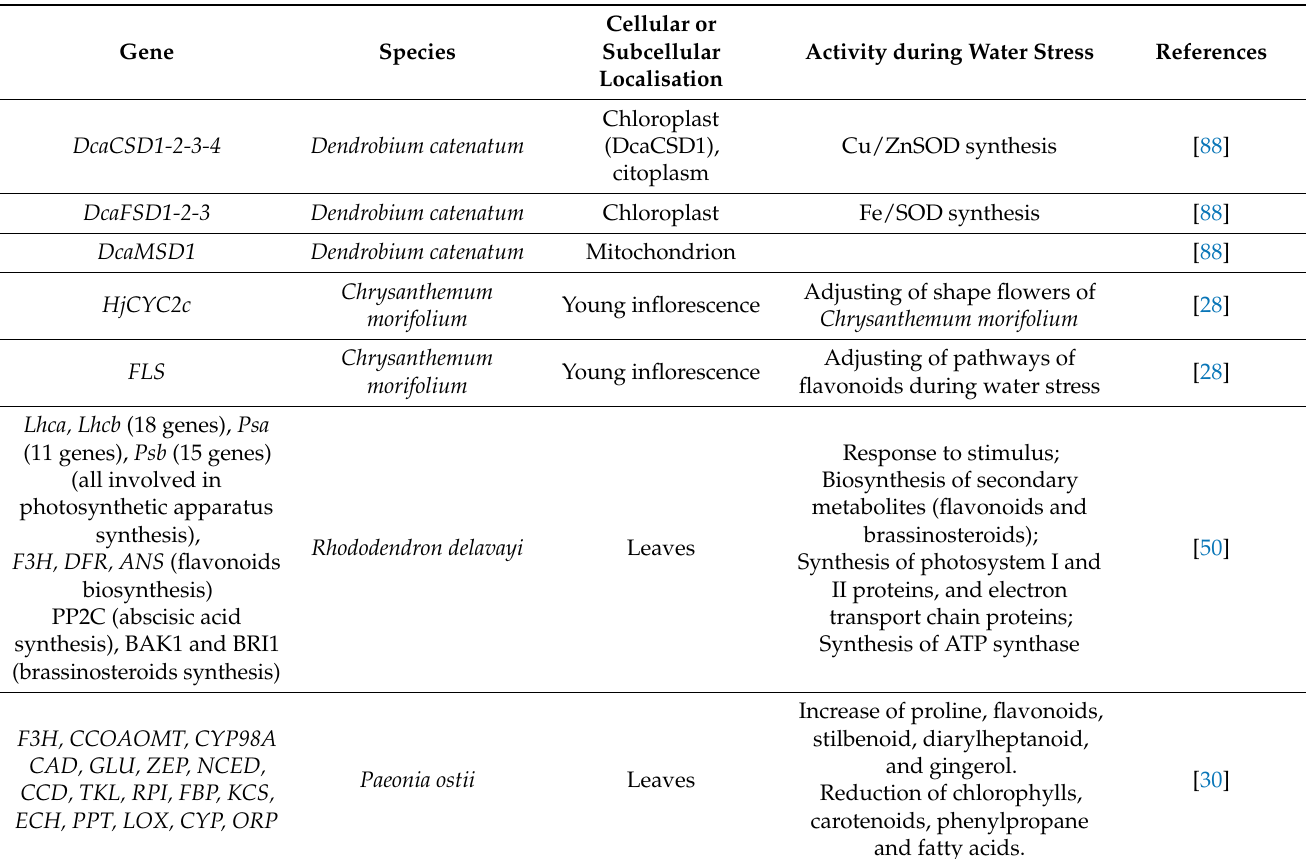
Table 3. Water stress responsive